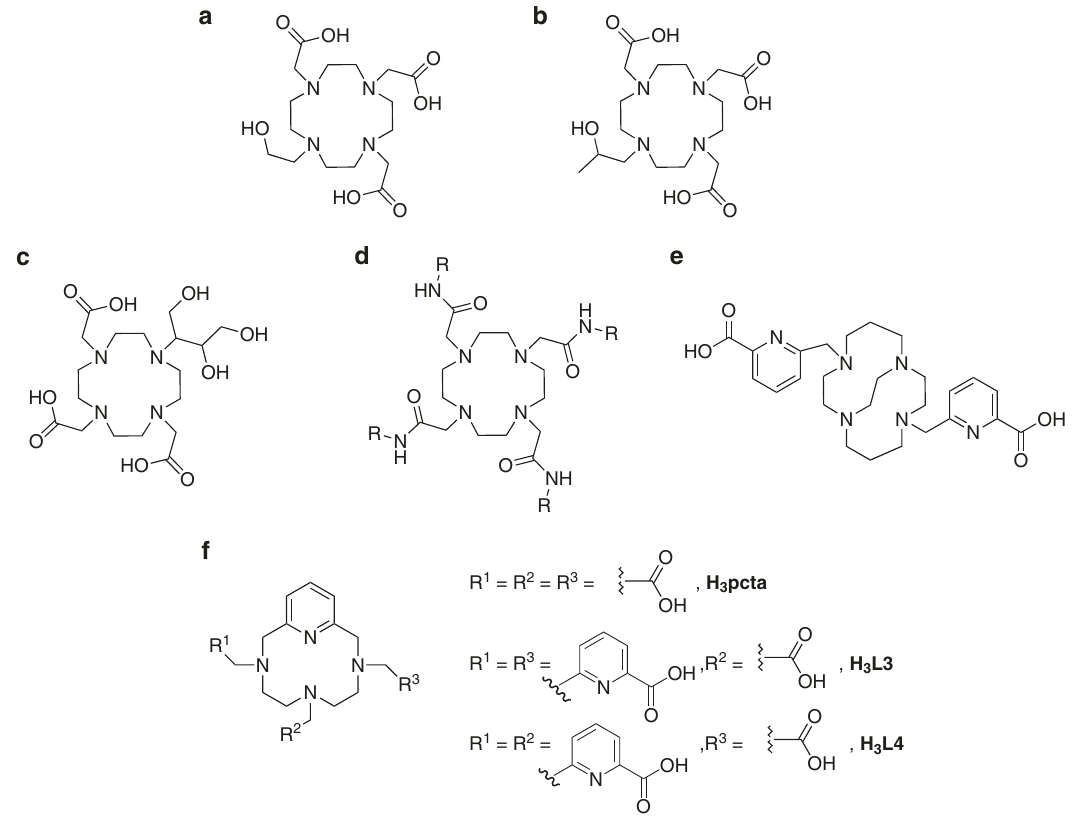
Fig. 5 Ligands where substitution around the N4-macrocyclic ring affects physicochemistry. a H 3 hedo3a, featuring a methyl group within the alcoholic pendant arm. b , c H 3 hpdo3a and H 3 do3a-butrol both have three pendant negatively charged acetate arms. d H 4 -(dota)(gly) 4 R = CH 3 , dtma, R = CH 2 COOH, comprising amido-functionalised N4-macrocyclic ligands with increased basicity. e H 2 cb-tedpa, featuring a reinforced N4-cyclam framework via an ethylene bridge. f H 3 pcta, H 3 L3 and H 3 L4 , featuring a heptadentate ligand incorporating pyridine directly into the ligand framework thus rigidifying and preorganising the